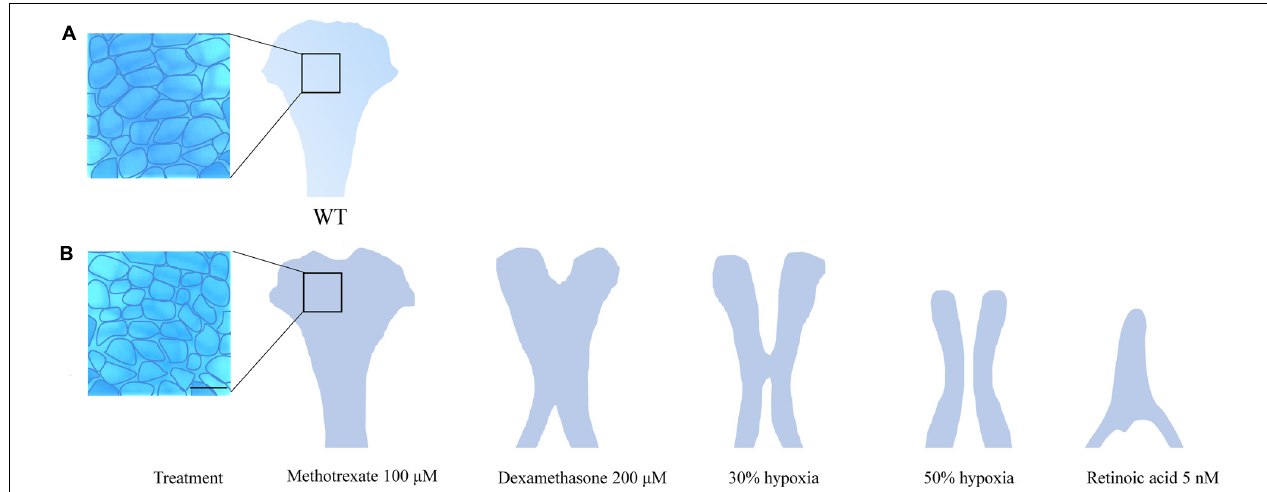
FIGURE 2 | (A) Wildtype ethmoid plate with associated stacking of chondrocytes. (B) Redrawn examples of ethmoid plate defects observed in zebrafish environmental factor exposure studies (Kuchler et al., 2018; Liu et al., 2020) (Methotrexate 100 µ M, Dexamethasone 200 µ M, retinoic acid 5 nM and hypoxia). A broad phenotypic range of ethmoid plate defects is observed, indicating that development of the ethmoid plate is affected variously by different compounds. Mild phenotypes include a rough edge to the anterior ethmoid plate, and differential cell morphology (round vs. elongated) and chondrocyte stacking is disordered, drawn from Liu et al. (2020) (scale bar 5 µ m). At the other end of the spectrum, phenotypes are observed in which ethmoid plate structures are (partially) missing, indicating effects on migration, differentiation and survival CNCCs. Moreover, some factors affect early as well as late craniofacial development, and various effects can occur though differential exposure times during specific sensitivity